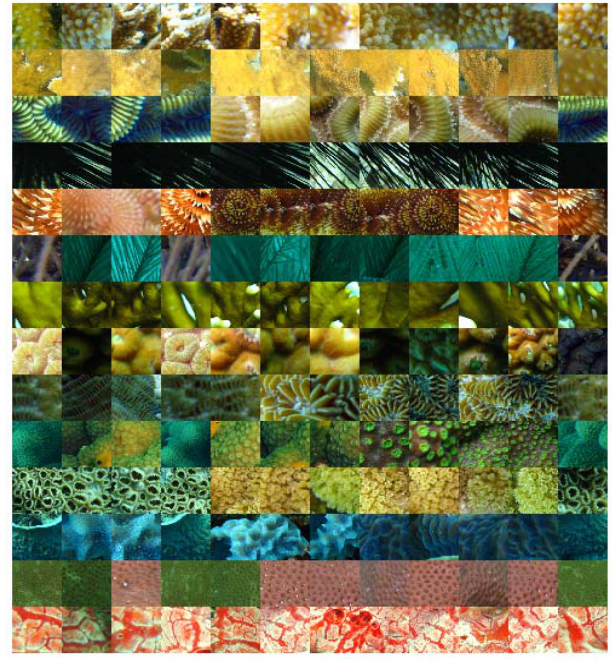
Figure A1. A subset of the RSMAS dataset; showing 12 examples, in columns, of each of the 14 classes (in rows from top to bottom: Acropora cervicornis (ACER), Acropora palmata (APAL), Colpophyllia natans (CNAT), Diadema antillarum (DANT), Diploria strigosa (DSTR), Gorgonians (GORG), Millepora alcicornis (MALC), Montastraea cavernosa (MCAV), Meandrina meandrites (MMEA), Montipora spp. (MONT), Palythoas palythoa (PALY), Sponge fungus (SPO), Siderastrea siderea (SSID) and tunicates